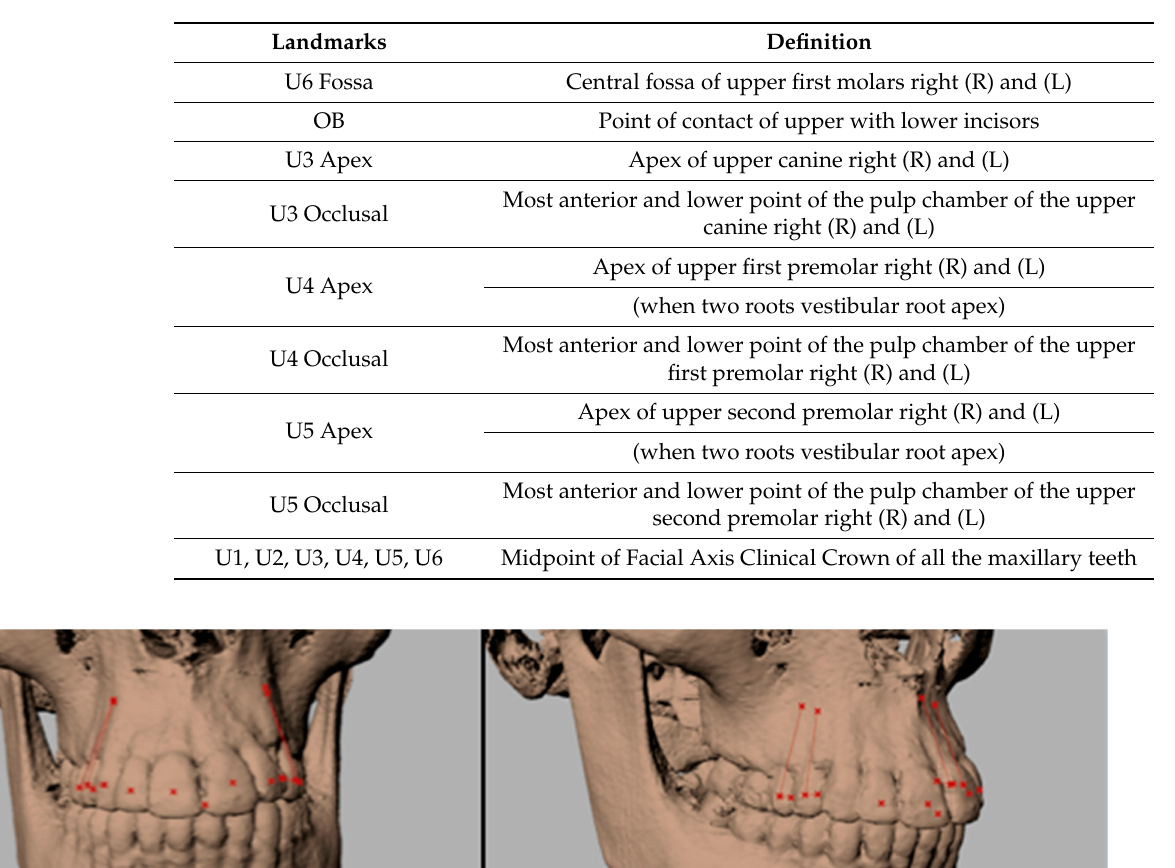
Table 1. Mimics landmarks. Anatomic points set on cone-beam computed tomography (CBCT) with Mimics Software for both sides.